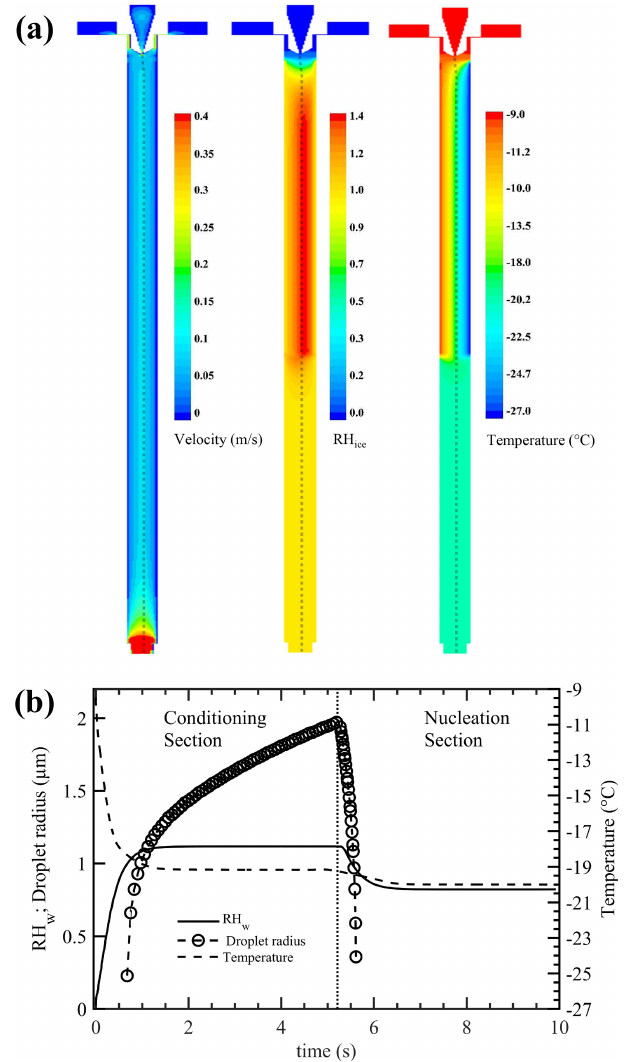
Figure 4. (a) Contours of CFD-calculated airflow velocity, RH ice , and temperature profiles within the ice chamber. Warm and cold walls of conditioning section are maintained at − 9 and − 27 ◦ C, respectively. The nucleation section is maintained at − 20 ◦ C. The dashed line shows the trajectory of a single INP within the aerosol lamina transiting through the chamber. (b) CFD-calculated temper- ature and RH w profiles of a potential INP released from the sample injection region to the outlet end of the chamber. Analytical calcu- lations of droplet growth and evaporation of such a potential INP (0.3µm in diameter) are also shown. The left and right sides of the vertical dotted line represent the conditioning and nucleation sec- tions, respectively. See the text for more details. Simulation results at other nucleation section temperatures are shown in Figs.